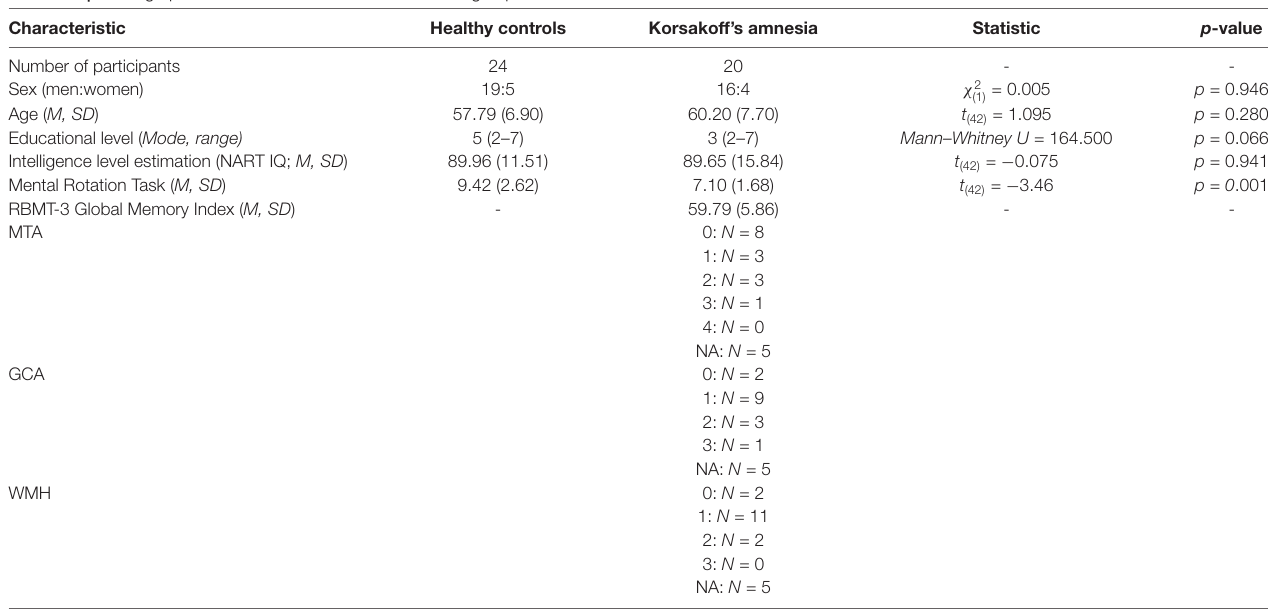
TABLE 1 | Demographical and other characteristics for both